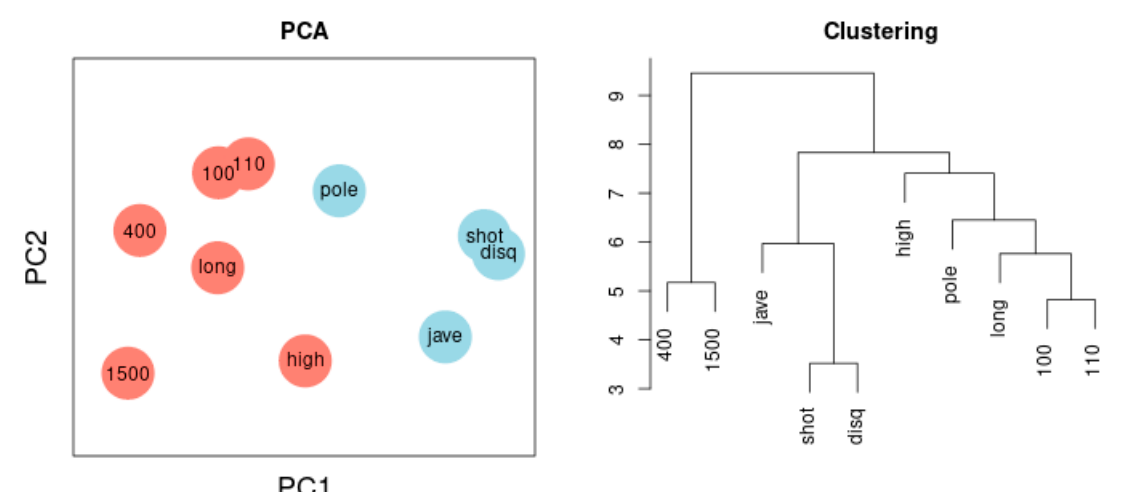
Figure 6. ( Left ) Principal Component Analysis. Two components are separated: lower extremities (red) versus upper extremities (blue). The first component represents 38%, the second 16% of total variance. Throwing discus and 1500-m run are most distant from each other reflecting the negative correlation between the two variables. ( Right ) Cluster dendrogram. Two clusters encompass disciplines reflecting lower extremities and disciplines reflecting upper extremities, a third cluster captures 400-m and 1500-m runs.